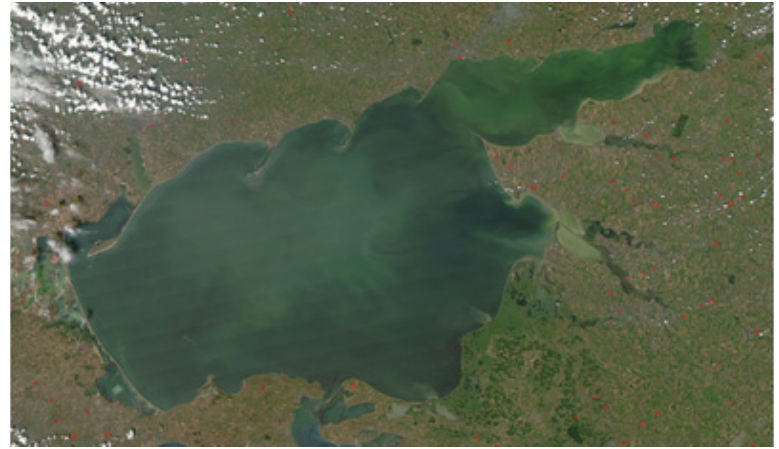
Figure 1. Satellite image of the Azov Sea (a moderate resolution spectroradiometer (MODIS) on the NASA Aqua satellite, date of access 10.10.2021).